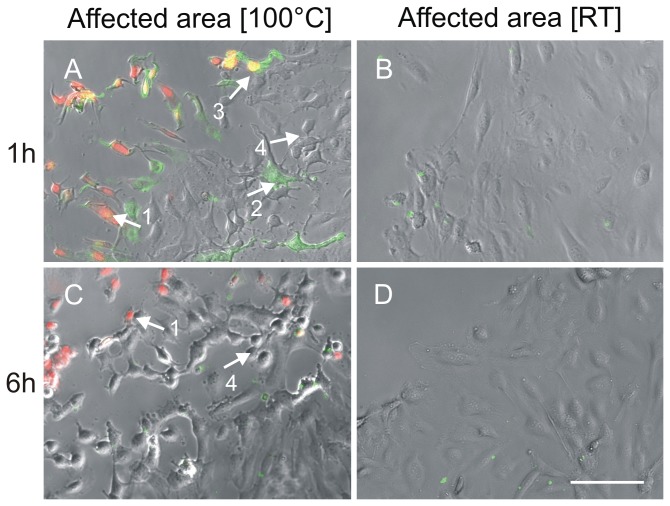
Necrotic and apoptotic cells after thermal damage.HUVEC were damaged using the two-ring stamp at 100 °C for 1 sec as described in material and methods and stained for necrotic cells (1: propidium iodide, red) as well as early apoptotic cells (2: Annexin V, green). One hour after thermal damage both necrotic as well as early apoptotic cells are present (A). In contrast, no cell death is seen after mechanical damage (B). 3: co-localisation, yellow: late apoptotic cells or necrotic cells. 4: vital but rounded cells at the adjacent area after thermal damage are typical for this region and are distinguishable in the phase contrast due to lack of staining. C: HUVEC at the adjacent area 6 h after thermal damage. Necrotic but no apoptotic cells are seen. D: No cell death is seen at 6 h after mechanical damage. Scale bar: 100 µm.